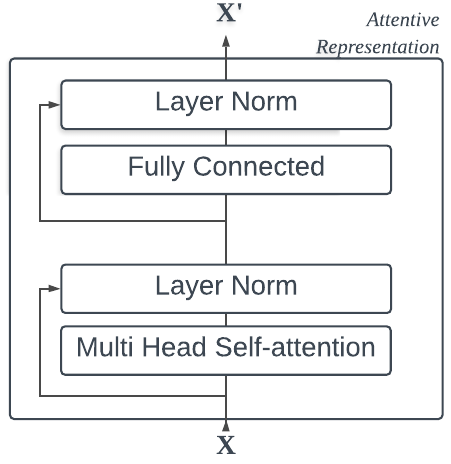
Figure 2. Attentive